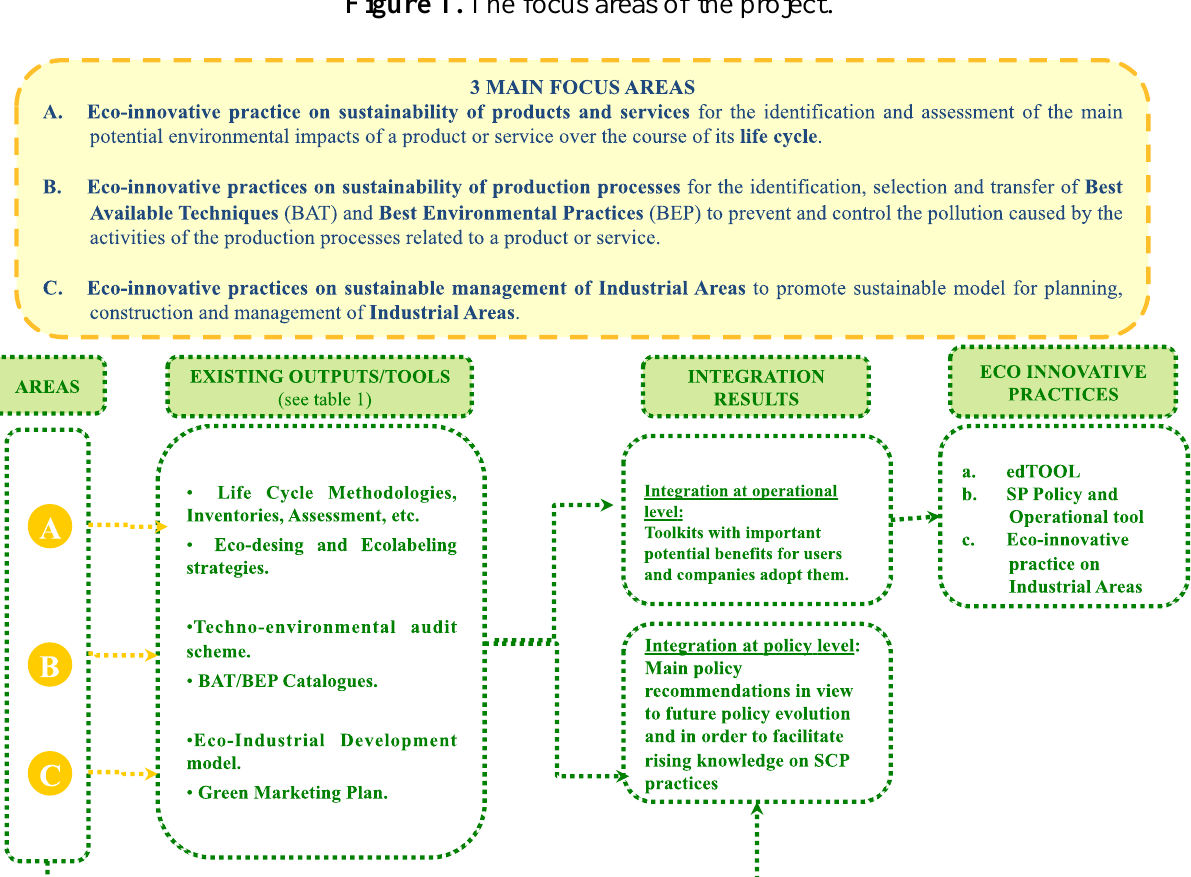
Figure 1. The focus areas of the